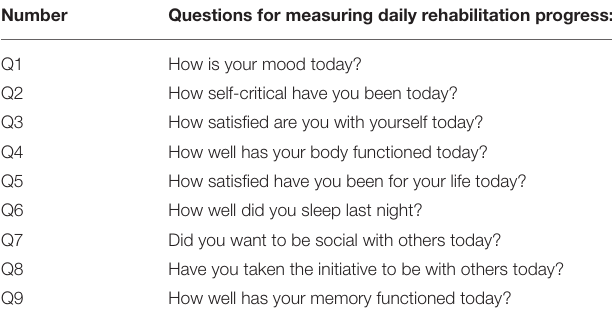
TABLE 1 | Questions for measuring daily rehabilitation progress. Number Questions for measuring daily rehabilitation